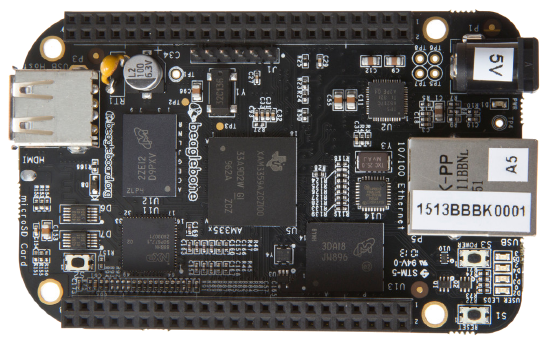
Figure 14. Beaglebone Black microcomputer overview.